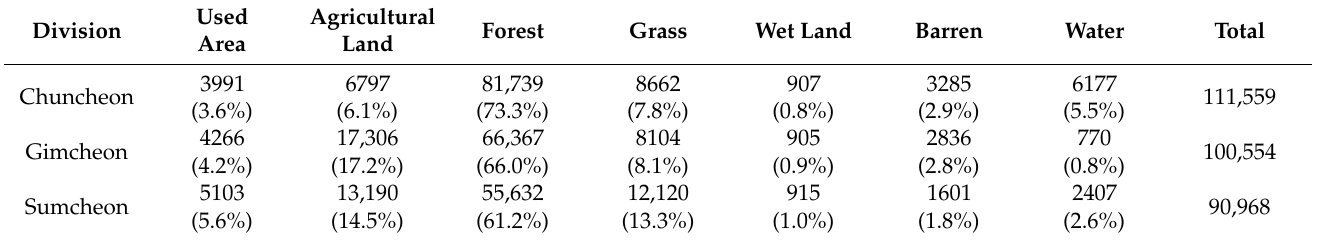
Table 1. Current land cover distribution in the three study cities based on Sd LCM (unit: